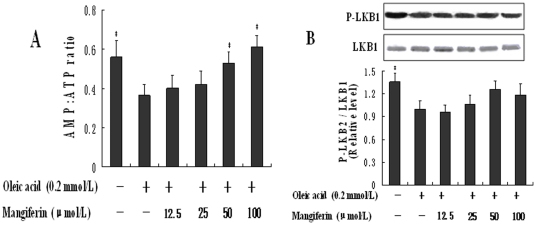
Effects of mangiferin on the ratio of AMP to ATP and LKB1 protein expression in HepG2 cells.HepG2 cells were incubated to 0.2 mmol/L oleic acid only or with different concentrations of mangiferin (12.5, 25, 50, 100 µmol/L) simultaneously for 24 h. The ratio of AMP to ATP was detected by HPLC (A). The LKB1 protein expression was carried out by western blot analysis (B). The experiments were repeated 3 times. Data are presented as means ± SD (n = 3). *
P<0.05 compared with only OA stimulation group.